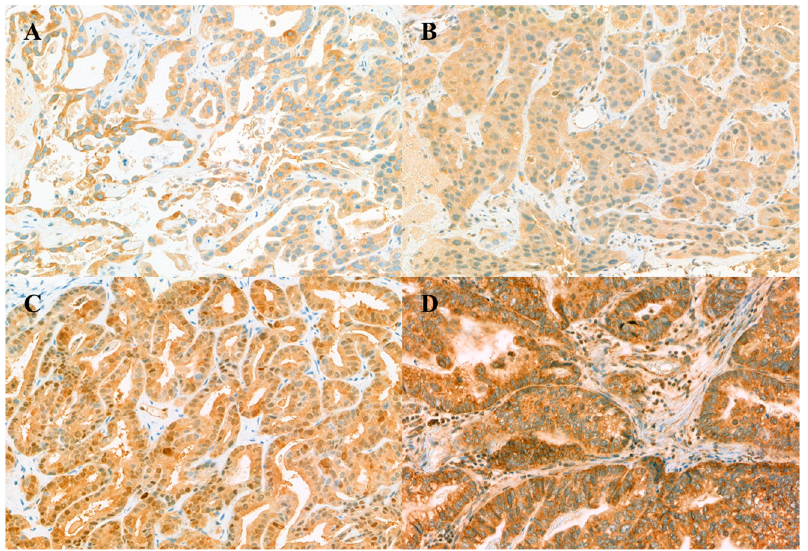
Figure 1. Immunohistochemical analysis of the intratumoral expression of proteins associated with gemcitabine transport and metabolism in patients with biliary tract cancers. ( A ) hENT1 in gallbladder (GB) cancer, ( B ) DCK in intrahepatic cholangiocarcinoma, ( C ) CDA in GB cancer, ( D ) RRM1 in GB cancer.